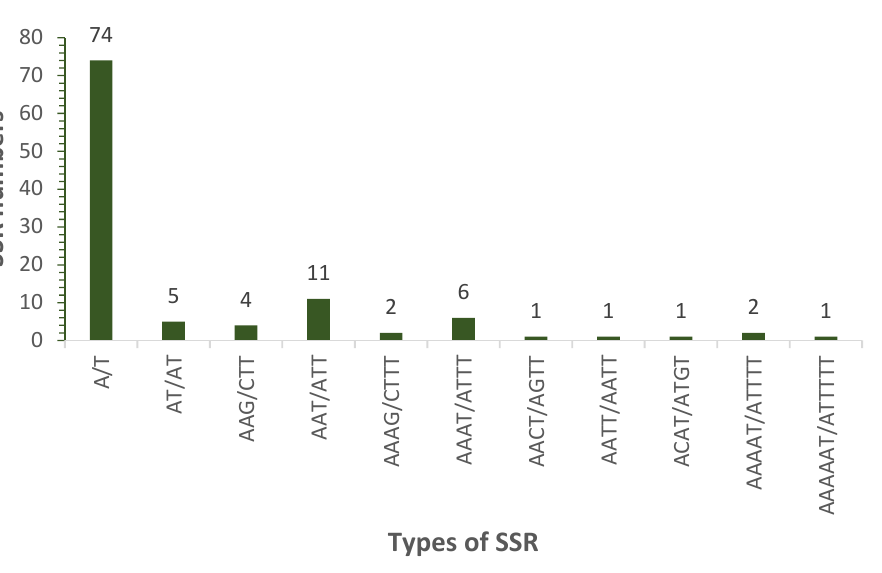
Figure 3. Analysis of SSRs in Fortunella venosa chloroplast genomes. (Type and abundance of SSRs).